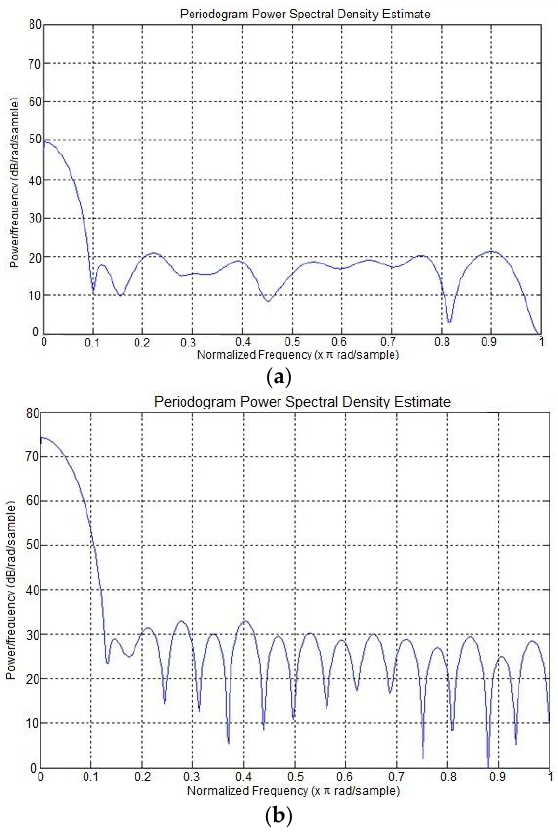
Figure 4. Power spectral density of pressure signals in ( a ) small column; ( b ) large column.